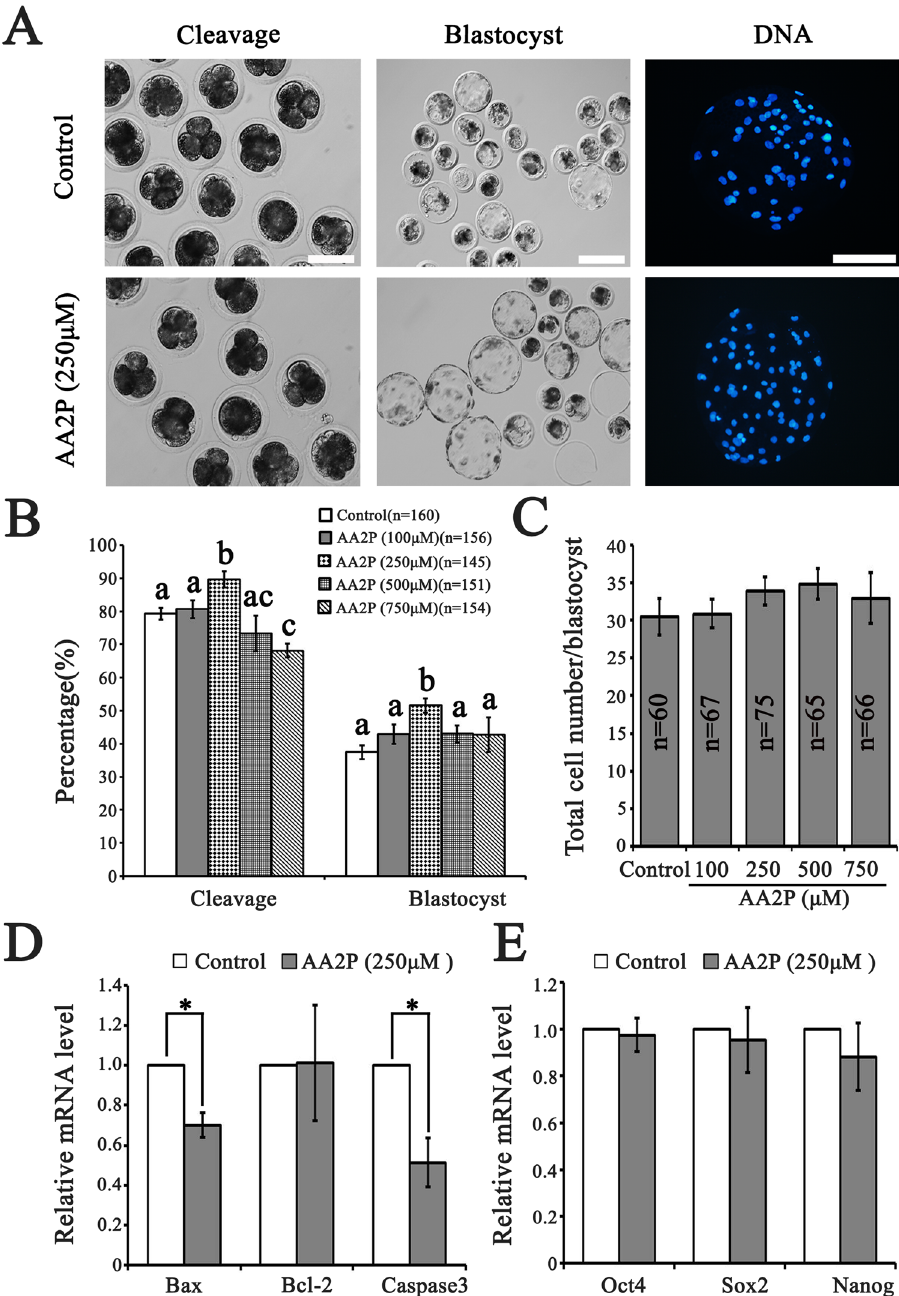
Figure 3. AA2P enhances the subsequent development of pig oocytes. ( A ) The representative images of parthenotes cleaved, developed to blastocyst and stained to show total cell number per blastocyst. Scale bar: 200 µ m. ( B ) Cleavage and blastocyst rates of parthenotes from control and AA2P treated groups. Different lowercase letters a, b and c indicate significant differences at P < 0.05 level. ( C ) The average total cell number per blastocyst from control and AA2P treated groups. ( D ) Relatvie mRNA levels of apoptosis-related genes ( Bax, Bcl-2 and Caspase3 ). * Indicates significant difference at P < 0.05 level. ( E ) Relative mRNA levels of pluripotency genes ( Oct4 , Sox2 and Nanog